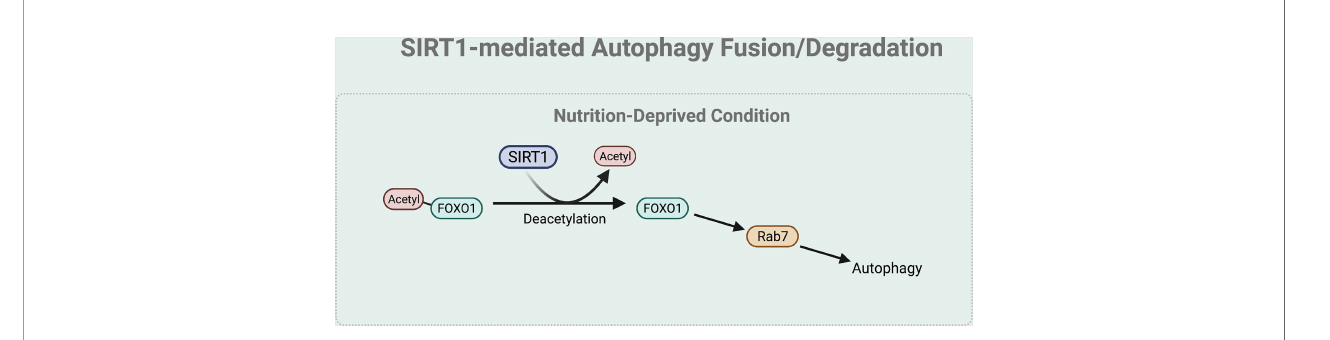
FIGURE 5 | SIRT1-mediated autophagy fusion regulation. Under nutrient-starved condition, SIRT1 mediates the autophagy and lysosome fusion by deacetylating FOXO1. The deacetylation of FOXO1 is necessary for the expression of Rab7 that helps to regulate this microtubule-dependent bidirectional transport of the autophagosome to